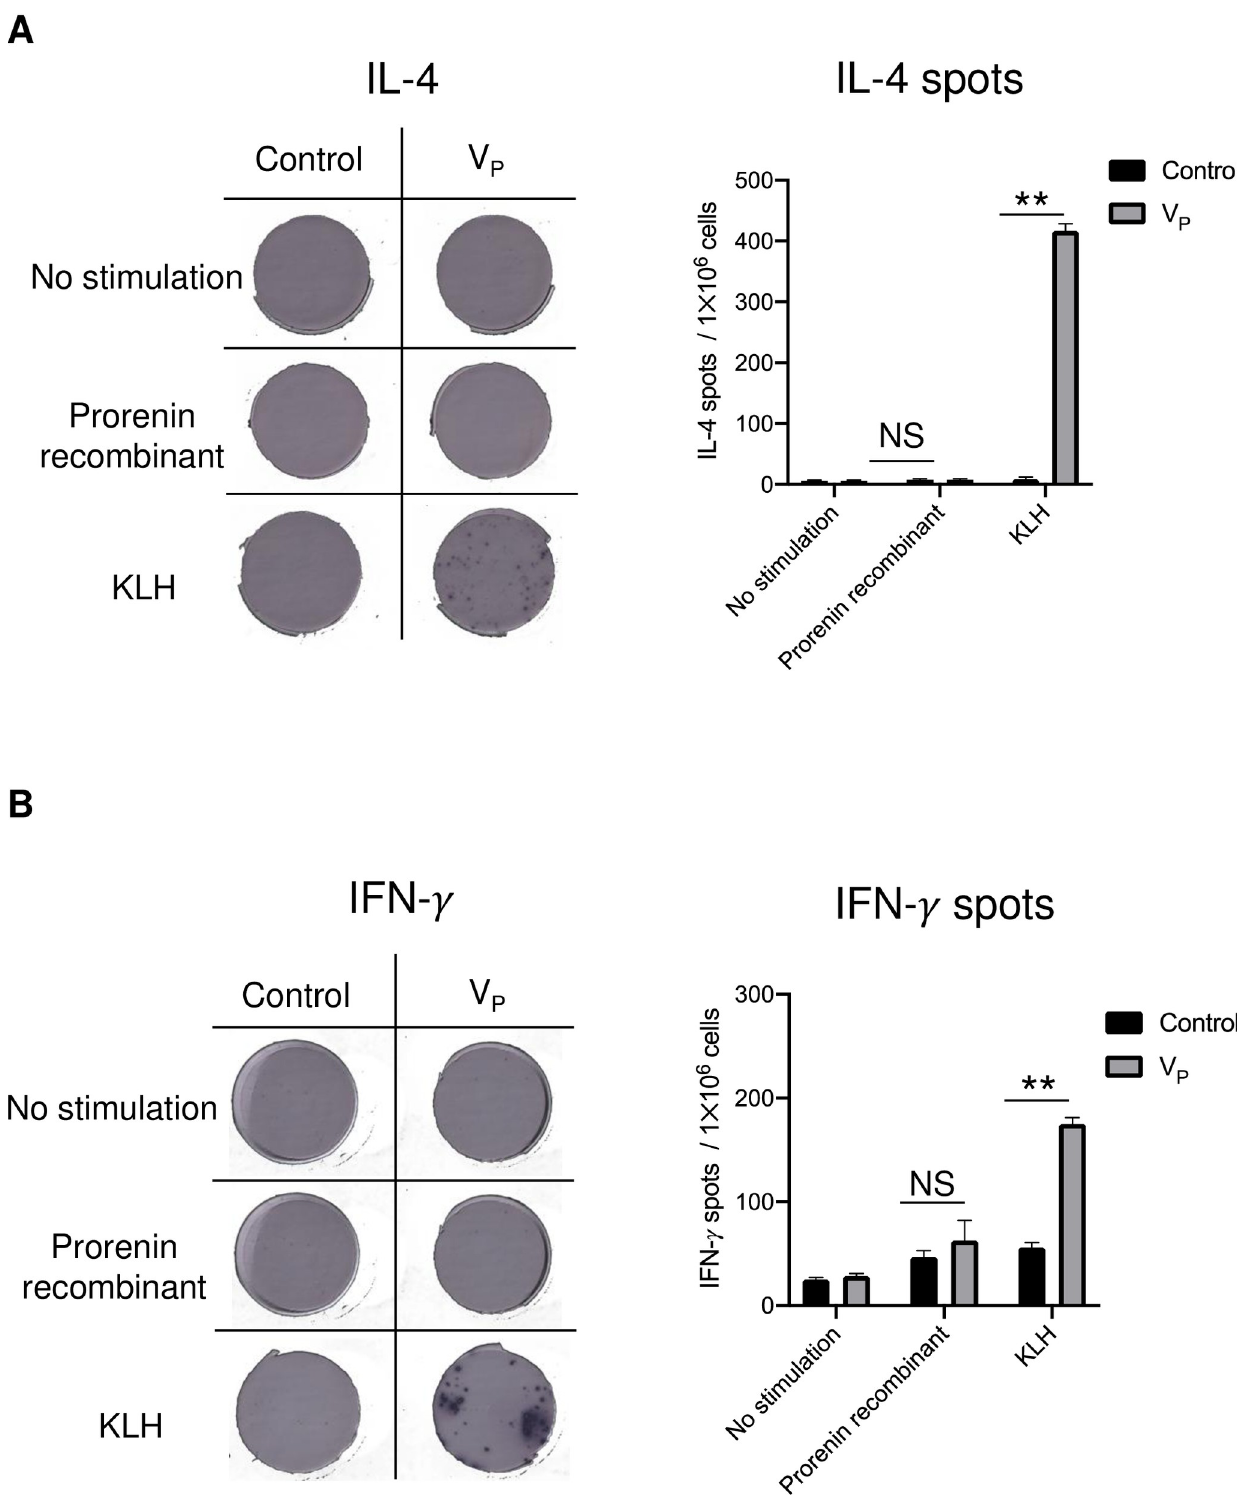
Fig 8. Enzyme-linked immune absorbent spot assay with splenocytes (1 × 10 6 cells) from C57BL/6 mice immunized with prorenin peptide vaccine (V P ). The production of interleukin 4 (A) and interferon-gamma (B) was detected as black spots. The bar graphs show the number of spots per membrane. Control is the age-matched C57BL/6 mouse without vaccination. KLH, keyhole limpet hemocyanin; IFN- γ , interferon-gamma; IL-4, interleukin 4; V P , prorenin peptide vaccine. �� p <